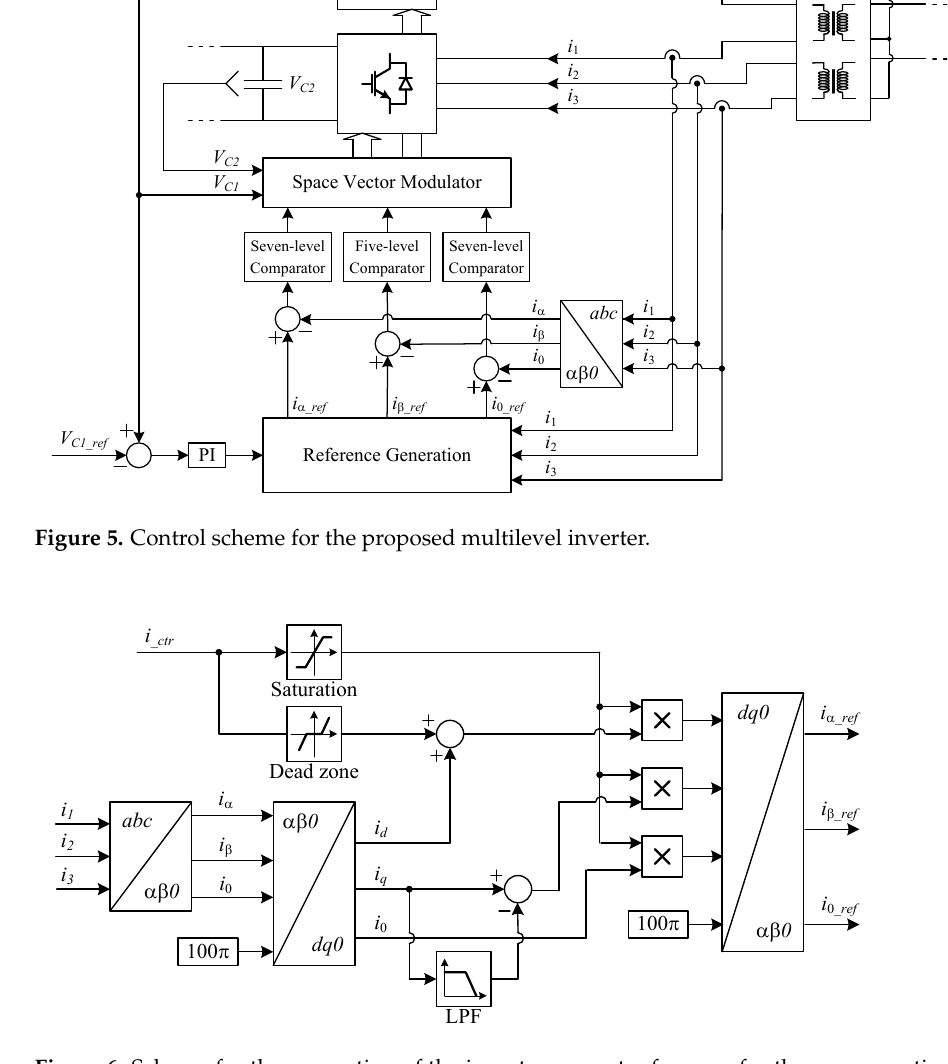
Figure 6. Scheme for the generation of the inverter current references for the compensation of the active power imbalance and linear loads.